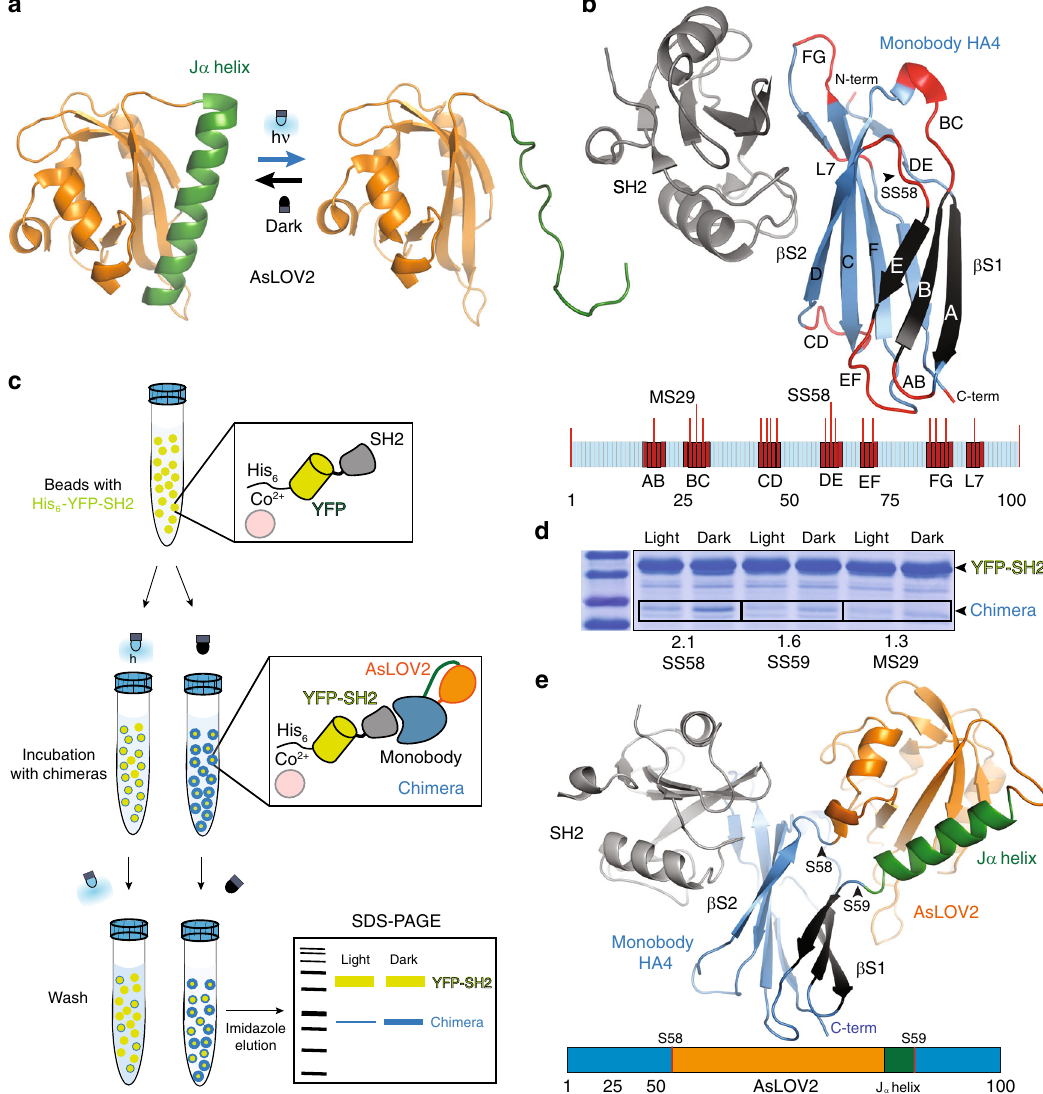
Fig. 1 Design and screens of AsLOV2-monobody chimeras and fi nal OptoMB. a Light-triggered conformational change of the J α helix (green) of AsLOV2. b Crystal structure of monobody HA4 (blue) bound to SH2 domain (gray) in an archetypal side-binding mode. The monobody fold consists of two β - sheets, β S1(black) and β S2 (light blue), and structurally conserved loops (red, L7 in some monobodies is part of Loop FG), where AsLOV2 was inserted in our chimeras. Loop DE, where AsLOV2 is inserted in OptoMB, is shown with an arrow. The cartoon below shows the relative size and location of loops (red), including positions of AsLOV2 insertion (red lines) and insertion sites of identi fi ed light-responsive chimeras: MS29 and SS58 (in OptoMB). c Schematic diagram of pull-down screens used to identify light-responsive chimeras. Co 2 + agarose beads (pink) were used to immobilize His 6 -YFP-SH2 (yellow-gray), which were then incubated with HA4-AsLOV2 chimeras (blue – orange) in either dark or light. After washing and eluting with imidazole, the eluents were resolved on SDS-PAGE to screen for differences in protein band intensity between samples exposed to different light conditions, which re fl ect differences in chimera SH2 binding. d Chimera pull-down screen results showing SDS-PAGE protein bands of two chimeras that bind better in the dark than in the light. These light-responsive chimeras have AsLOV2 inserted in either Loop BC (MS29) or Loop DE (SS58, SS59); the fold difference in band intensity between dark and light binding conditions is shown for each chimera (the complete SDS-PAGE gel of this pull down is shown in Supplementary Fig. 1a). Pull-downs were repeated at least twice observing similar results. e Energy-minimized structural model of the dark conformation of OptoMB with AsLOV2 (orange with the J α helix in green) inserted in position SS58 of HA4 (blue and black), interacting with the SH2 domain (gray). Source data are provided as a Source Data fi